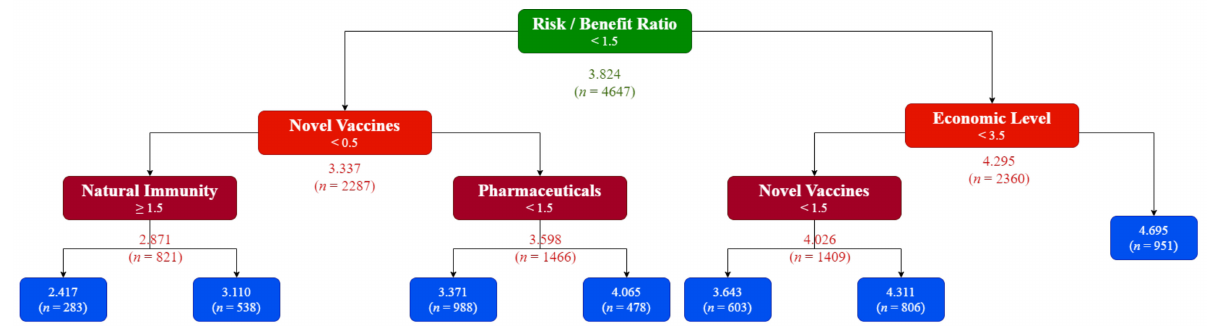
Figure 1. Decision tree for prediction of dental students’ willingness to receive COVID-19 vaccines, February 2021 ( n = 6639). The values inside the colored blocks represent the cutoffs of the answers for each predictor when “No” = 0, “Not Sure” = 1, and “Yes” = 2. The values below the colored blocks represent the cutoff response to the COVID-19 vaccination willingness question when “Totally Disagree” = 1, “Disagree” = 2, “Not Sure” = 3, “Agree” = 4, and “Totally Agree” =